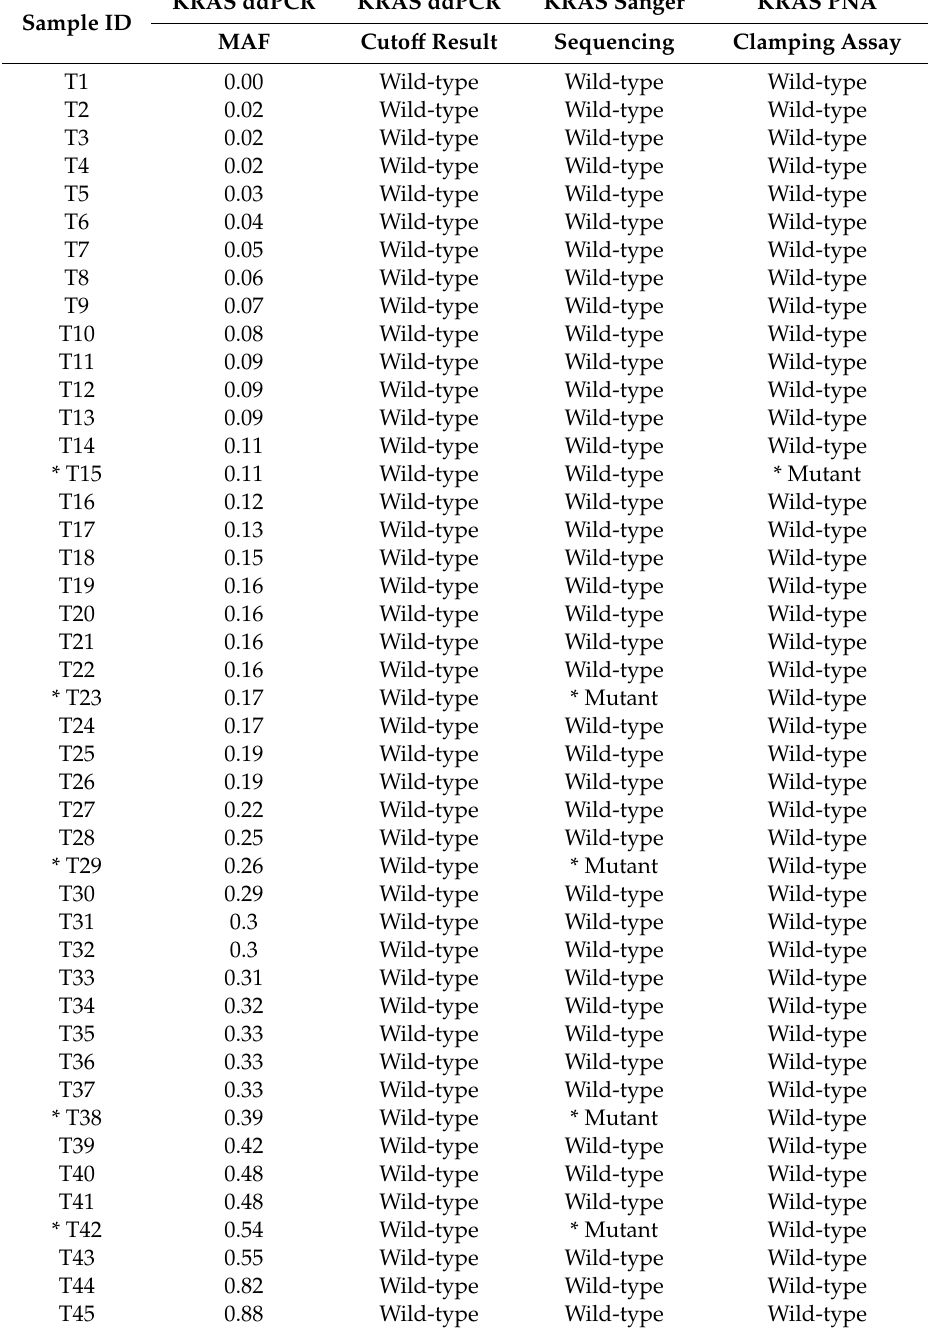
Table 4. Comparative analysis of KRAS G12 / 13 mutation detection by ddPCR, Sanger sequencing, and peptide nucleic acid (PNA) clamping